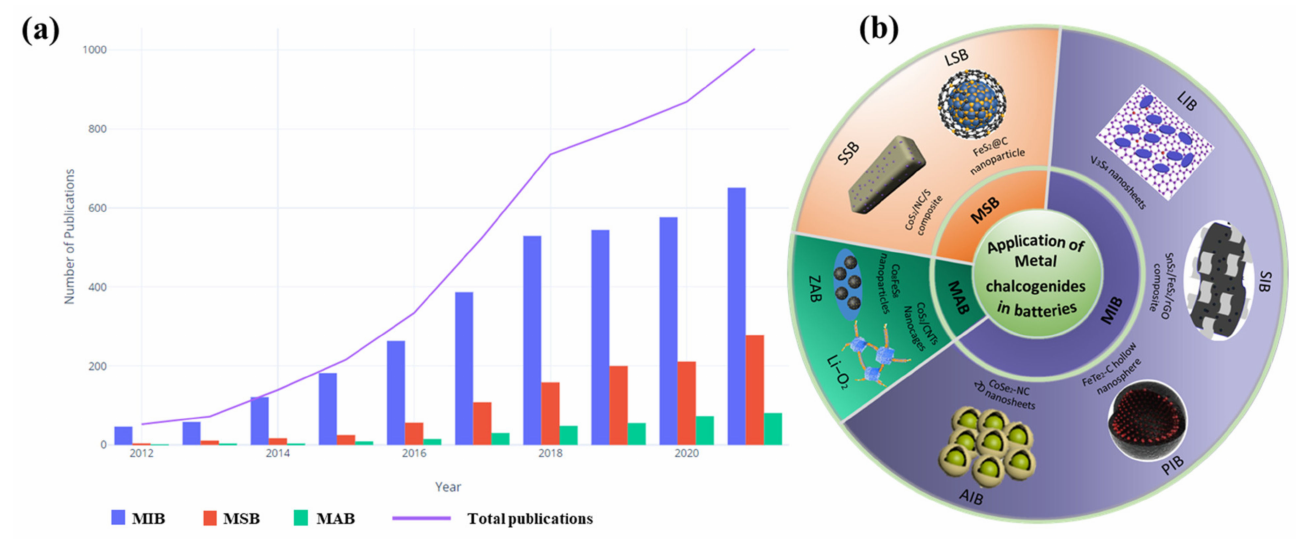
Figure 11. ( a ) Research trends for many published papers on metal chalcogenides for MIB, MSB, and MIB ( b ) Pie chart of Chalcogenides for Metal batteries in the last decade, with imbedded